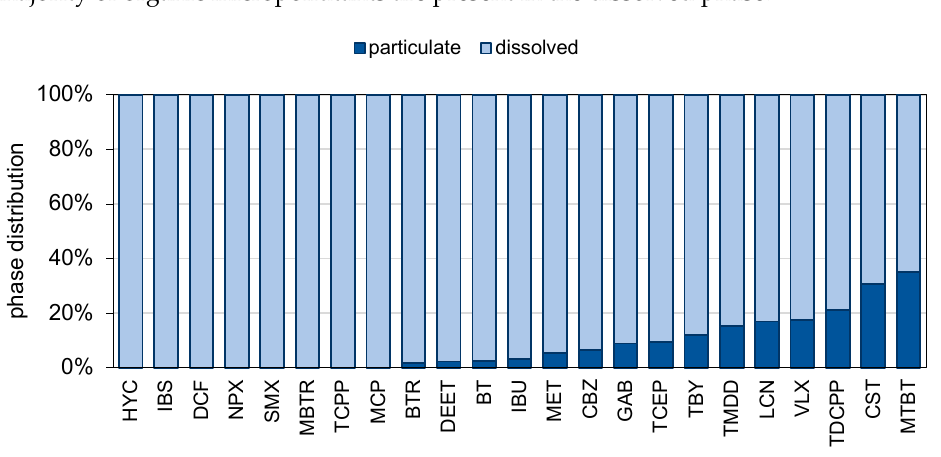
Figure 3. Phase distribution of wet-weather sampling WW1 for S1 for 23 OMPs.